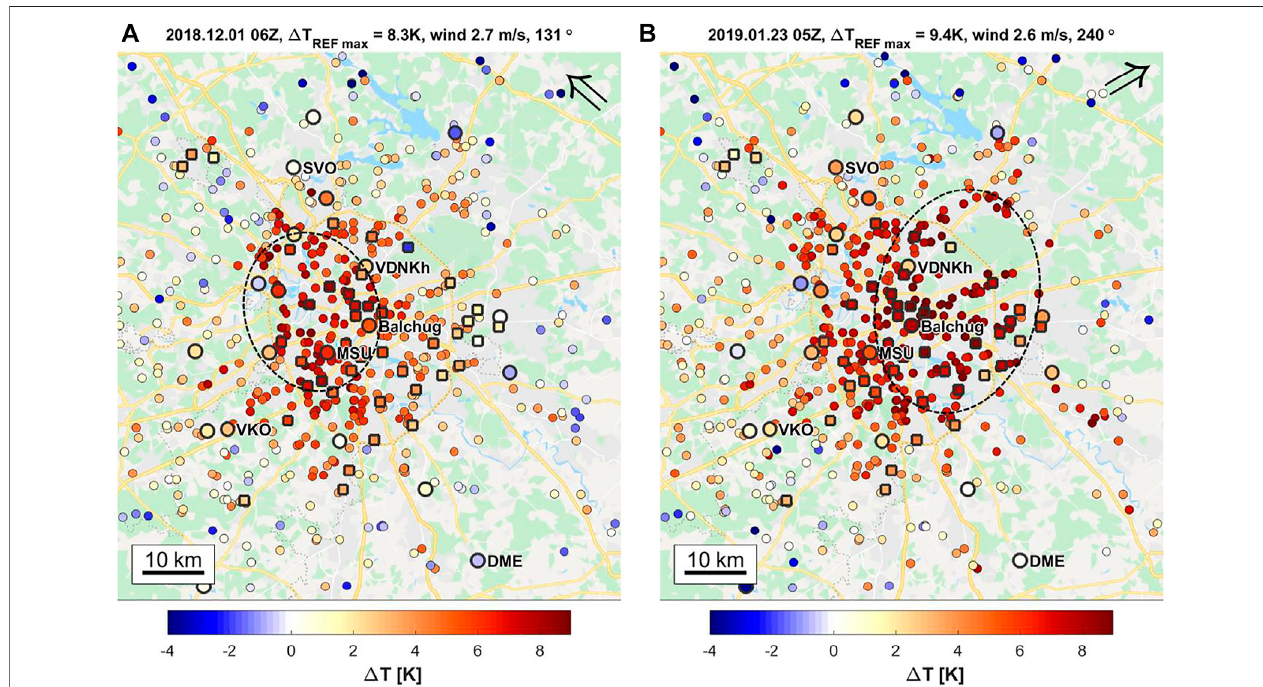
FIGURE 11 | Spatial patterns of UHI intensity Δ T for two speci fi c winter cases demonstrating an UHI shift to the leeward side of the city by south-easterly (A) and south-westerly (B) winds.Symbolsaresimilarto Figure4 .Thearrowinthetoprightcornershowsthe10-mwinddirectionaccordingtoERA5reanalysis.Thedottedline indicates the area with maximum Δ T . Digits in the caption indicate date and time, maximum Δ T according to REF data, ERA5 wind speed and